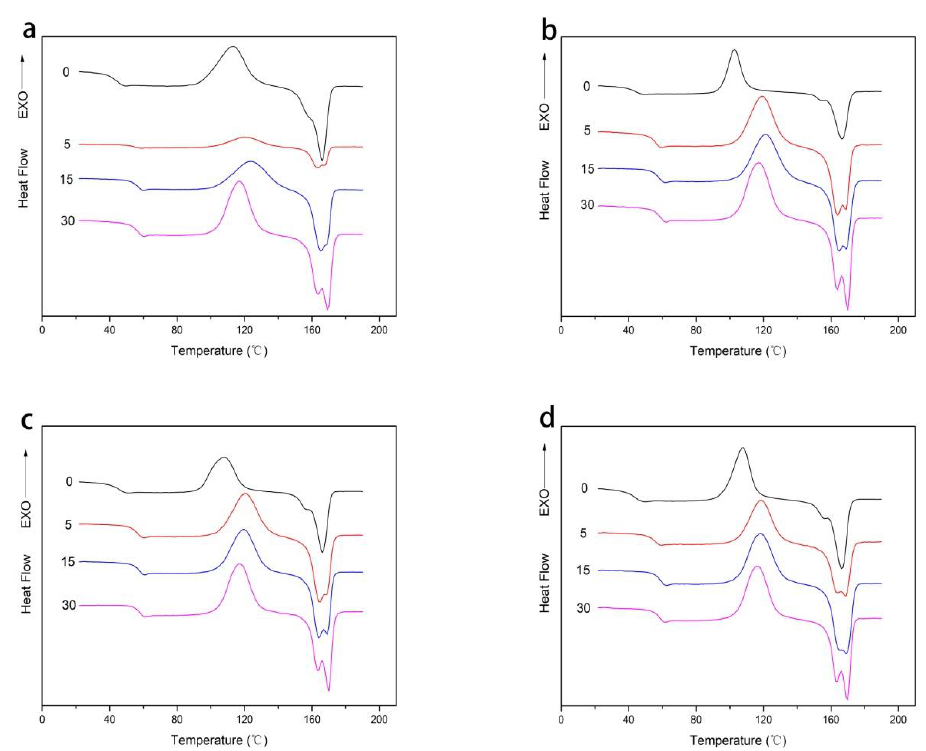
Figure 4. Di ff erential scanning calorimetry (DSC) curves of ( a ) PLA, ( b ) PLA / Ti5, ( c ) PLA / Ti10, and ( d ) PLA / Ti20 composite films treated by high pressure contacting with ethanol solution on day 0, 5, 15, and 30. Table 3. The thermal properties of PLA/nano-TiO 2 composite films after high pressure treatment.